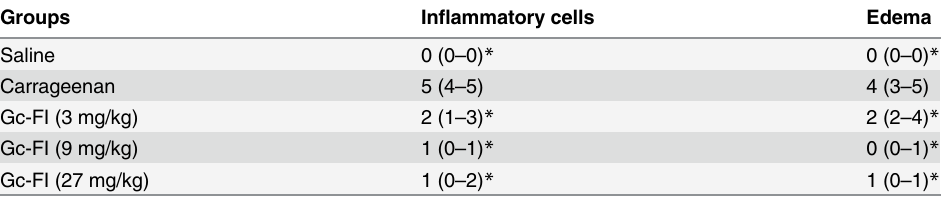
Table 3. Histopathological analysis (scores) of subplantar tissues after treatment s.c. rats with Gc-FI.